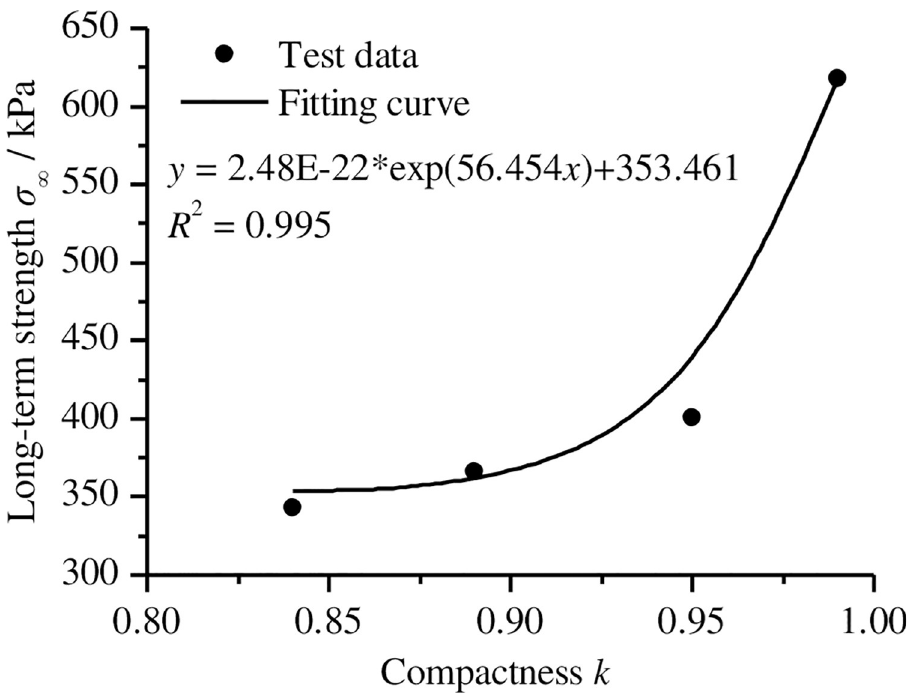
Fig 10. The relationship between long-term strength of remoulded loess and compactness.